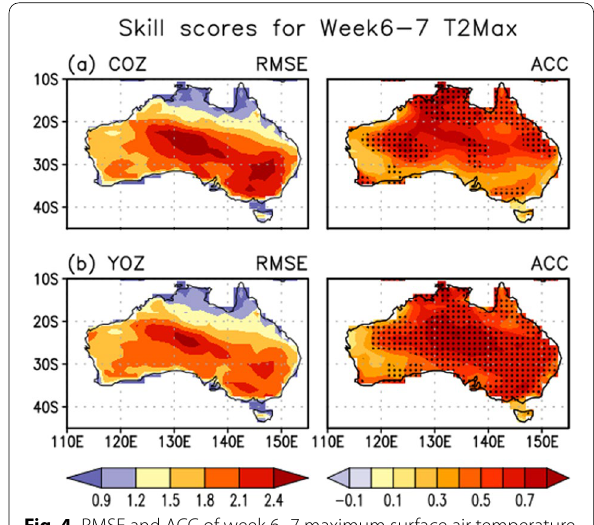
Fig. 4 RMSE and ACC of week 6–7 maximum surface air temperature (T2Max) in a COZ and b YOZ experiments. In the right column, the values which are statistically significant at the 95% confidence level are